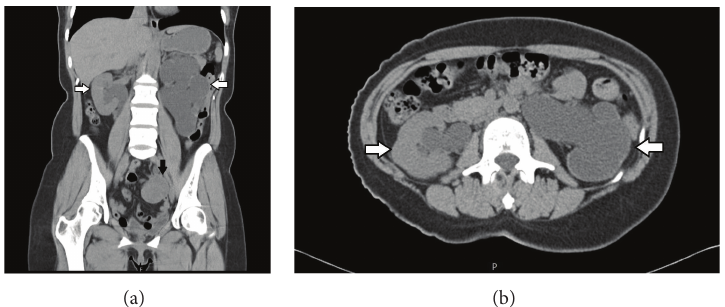
Figure 1: Pelvic CT (computed tomography) showed 4.5 cm sized left adnexal mass (black arrow in (a)) abutting with and obstructing the left distal ureter, resulting in severe left hydroureteronephrosis with complete loss of the left renal parenchyma; it also showed right mild hydroureteronephrosis without definite obstructive lesion (white arrows in (a) and